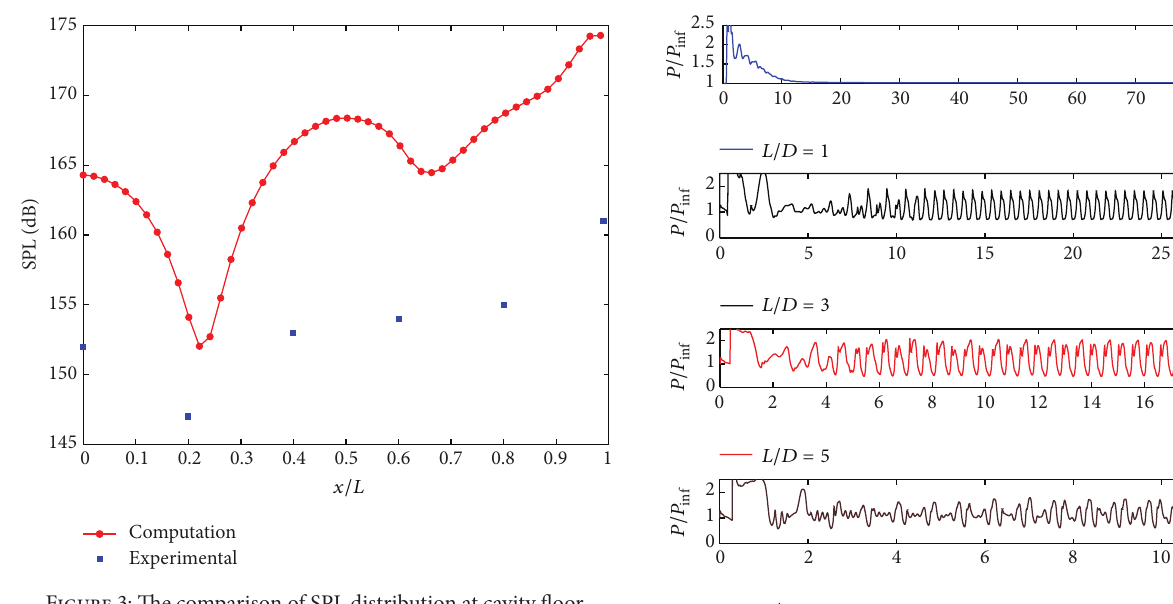
Figure 3: The comparison of SPL distribution at cavity floor.